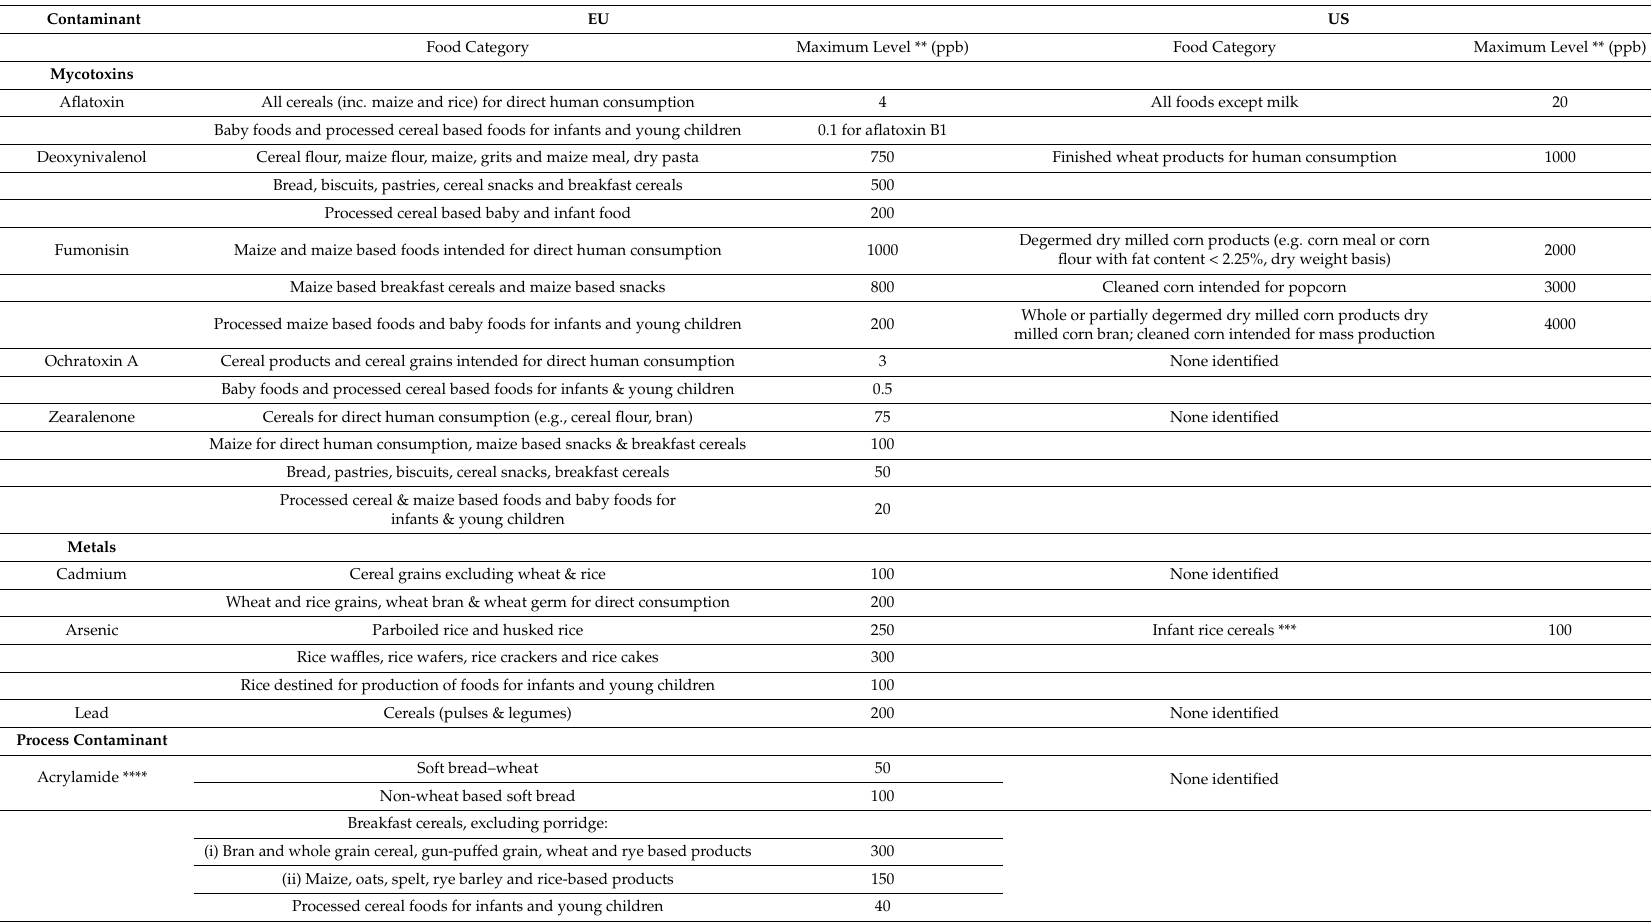
Table 3. Comparison of regulatory guidance in the EU and US for foods for human consumption concerning (i) maximum levels of total mycotoxins permitted; (ii) maximum levels (EU) or guidance values (US) for metals; and (iii) benchmark levels (EU only) for acrylamide.